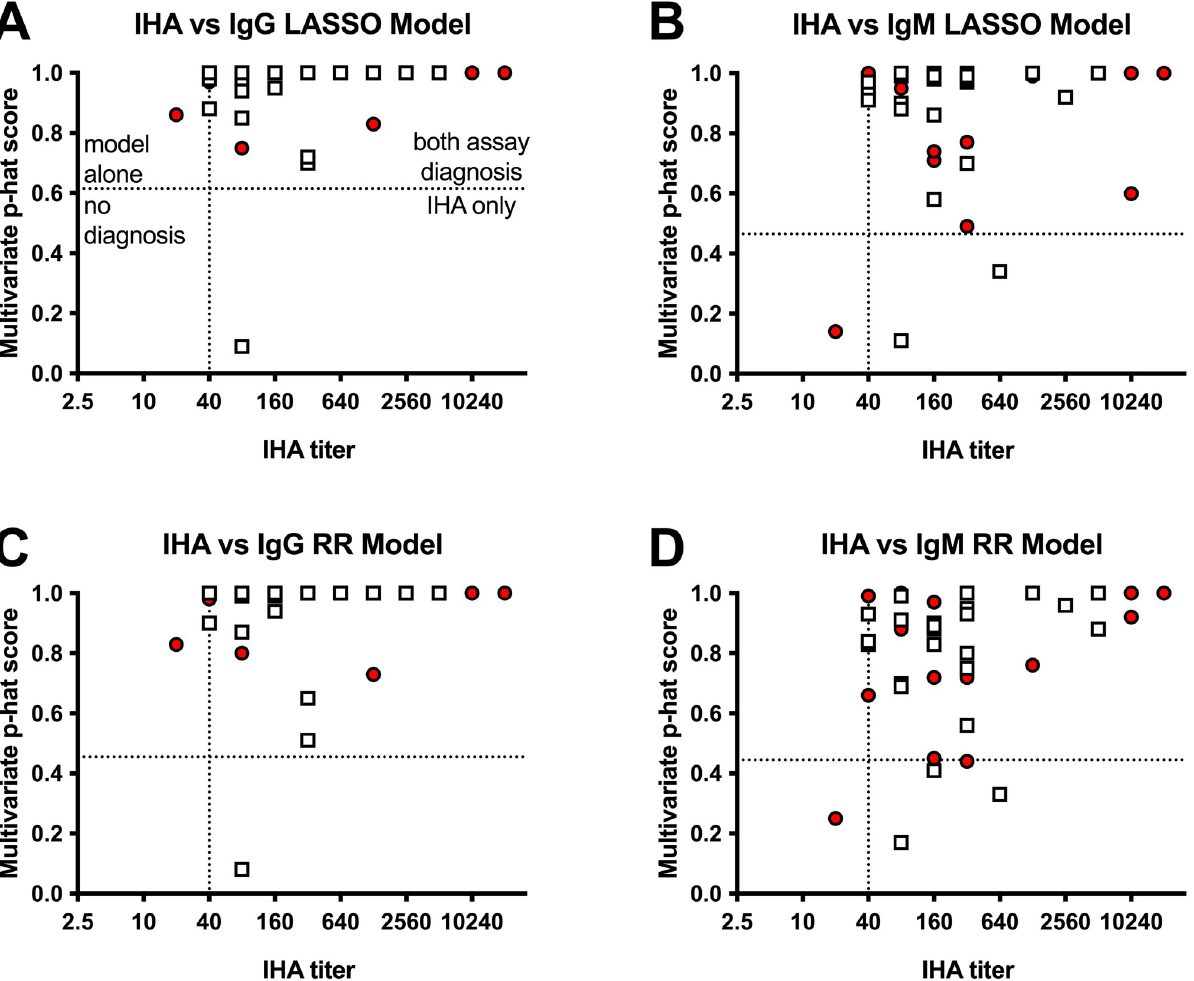
Fig 6. Comparison of the IHA results to the multivariate serology assay. IHA results (X-axis) and the multivariate p-hat probability score (Y-axis) are shown for the same sample collected from culture confirmed melioidosis patients. The different multivariate models are shown in separate panels (A-D). The day 0 (red circle) and day 21 (white squares) are shown. The cutoff for the IHA assay is 1:40 and the multivariate model cut-offs are consistent as shown in Table 5. The interpretation of the cutoff panels and which assay would correctly diagnose melioidosis is shown in panel A. A total of 40 samples that have both IHA and multivariate model values were